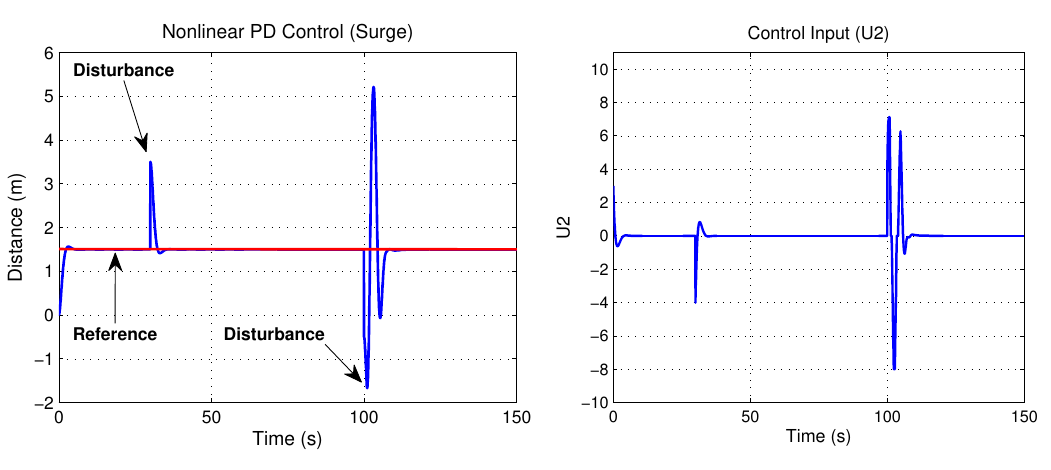
Figure 9. Surge movement and its control input U2.